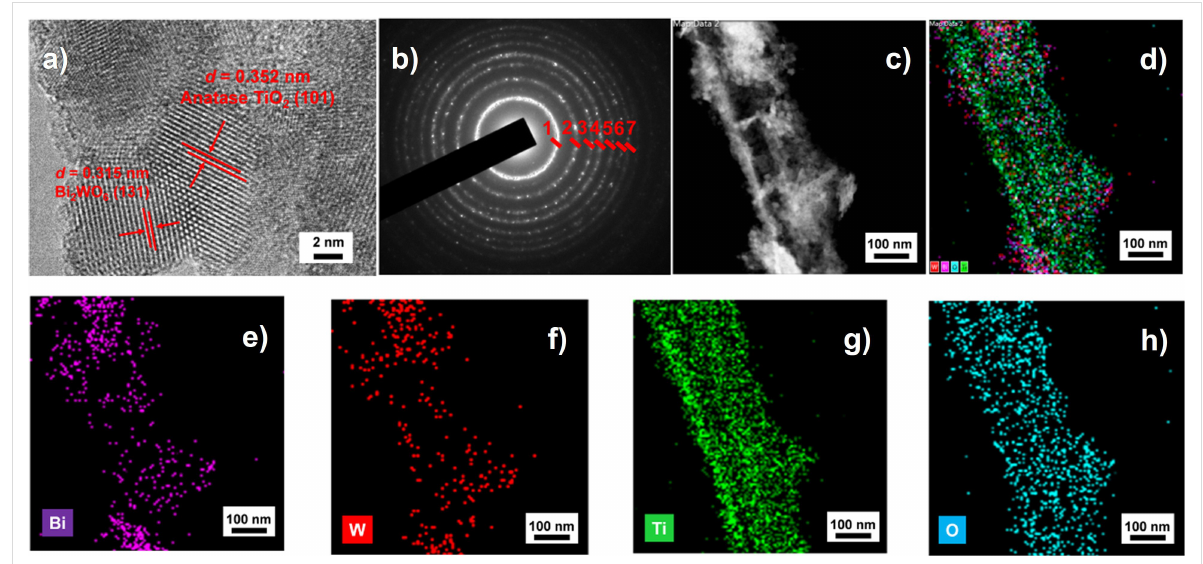
Figure 4: (a) HR-TEM image, (b) SAED pattern, and (c − h) EDX element mapping images of Bi, W, Ti, and O elements of the composite nanotube surface in the hierarchical 70% − Bi 2 WO 6 /TiO 2 -NT nanocomposite.